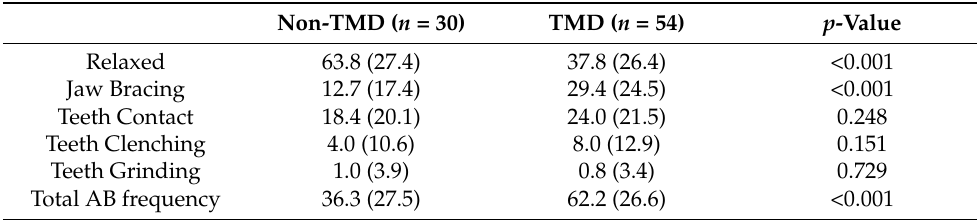
Table 1. Mean (SD) frequencies of awake bruxism behavior of participants with and without tem- poromandibular disorders.